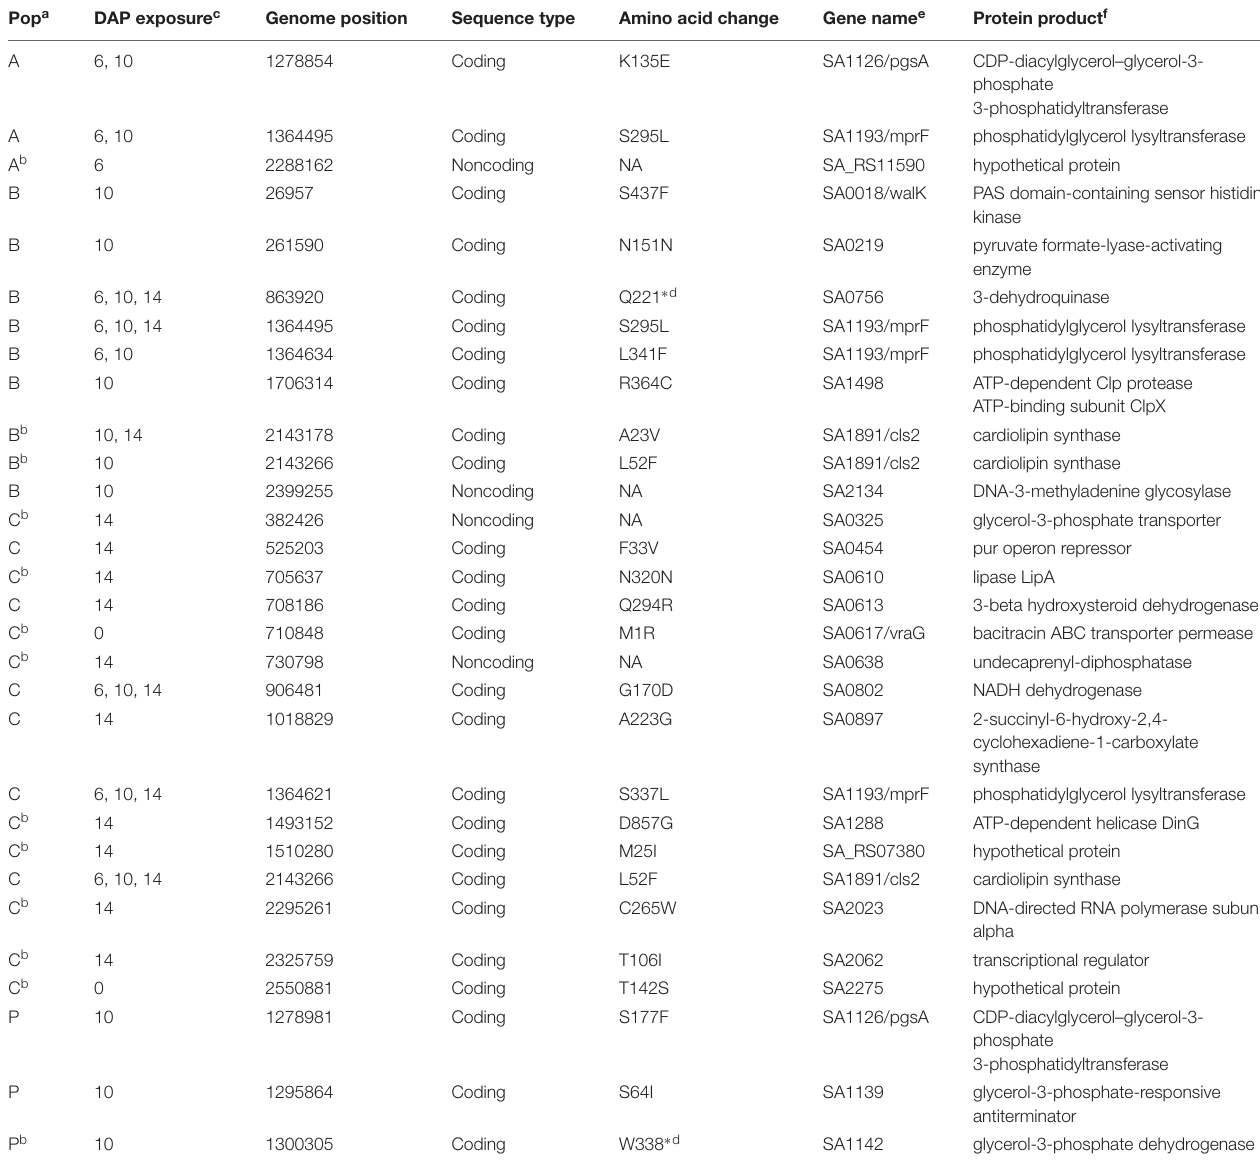
TABLE 1 | SNP acquisition in bioreactor and serial passaged Staphylococcus aureus populations exposed to